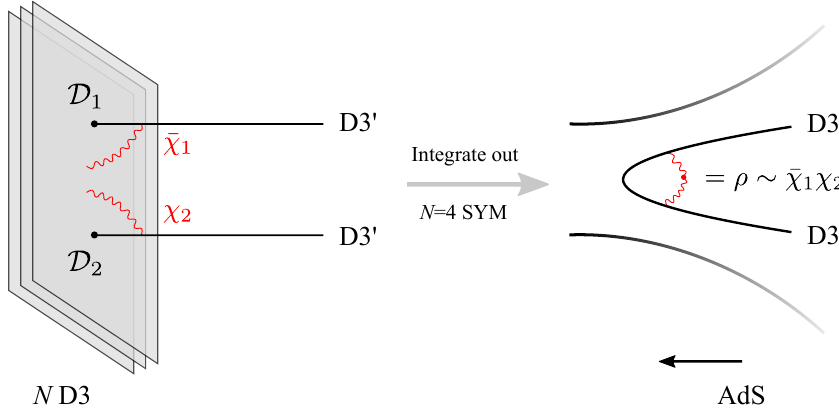
Figure 8 . The string theory interpretation of our rewritings. The determinant operators would correspond to two extra D3 branes intersecting perpendicularly with a stack of D3 branes.